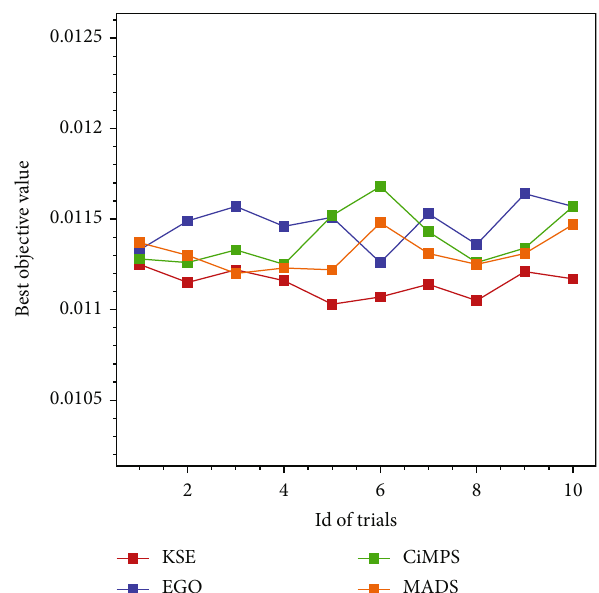
Figure 15: The results of ten trials of each method.